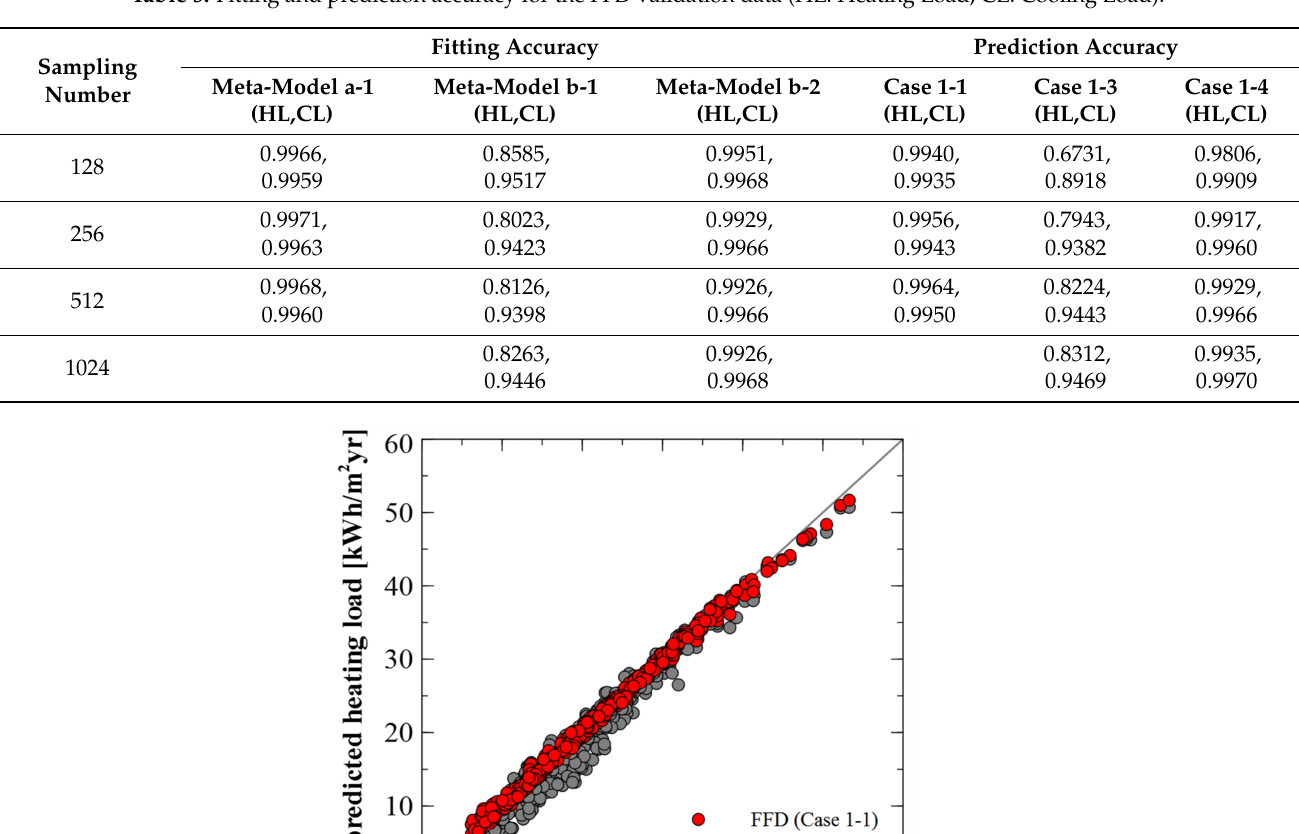
Table 5. Fitting and prediction accuracy for the FFD validation data (HL: Heating Load, CL: Cooling Load).